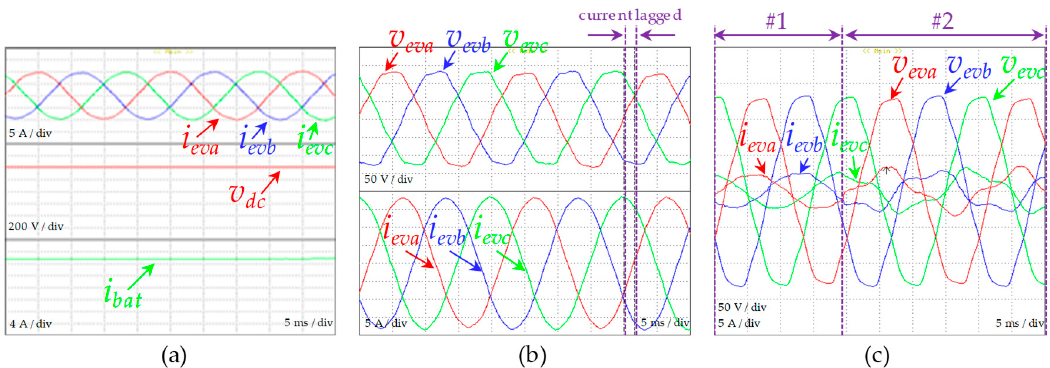
Figure 24. Experimental results of the off-board EVBC compensating power quality problems: ( a ) During 50 ms in the G2V mode-grid-side currents (i eva , i evb , i evc ), dc-link voltage (v dc ), and EV battery current (i bat ); ( b ) during 50 ms compensating power quality problems related with power factor-grid-side currents (i eva , i evb , i evc ) and voltages (v ga , v gb , v gc ); ( c ) during 50 ms compensating power quality problems related with current harmonics-grid-side currents (i eva , i evb , i evc ) and voltages (v ga , v gb , v gc ).